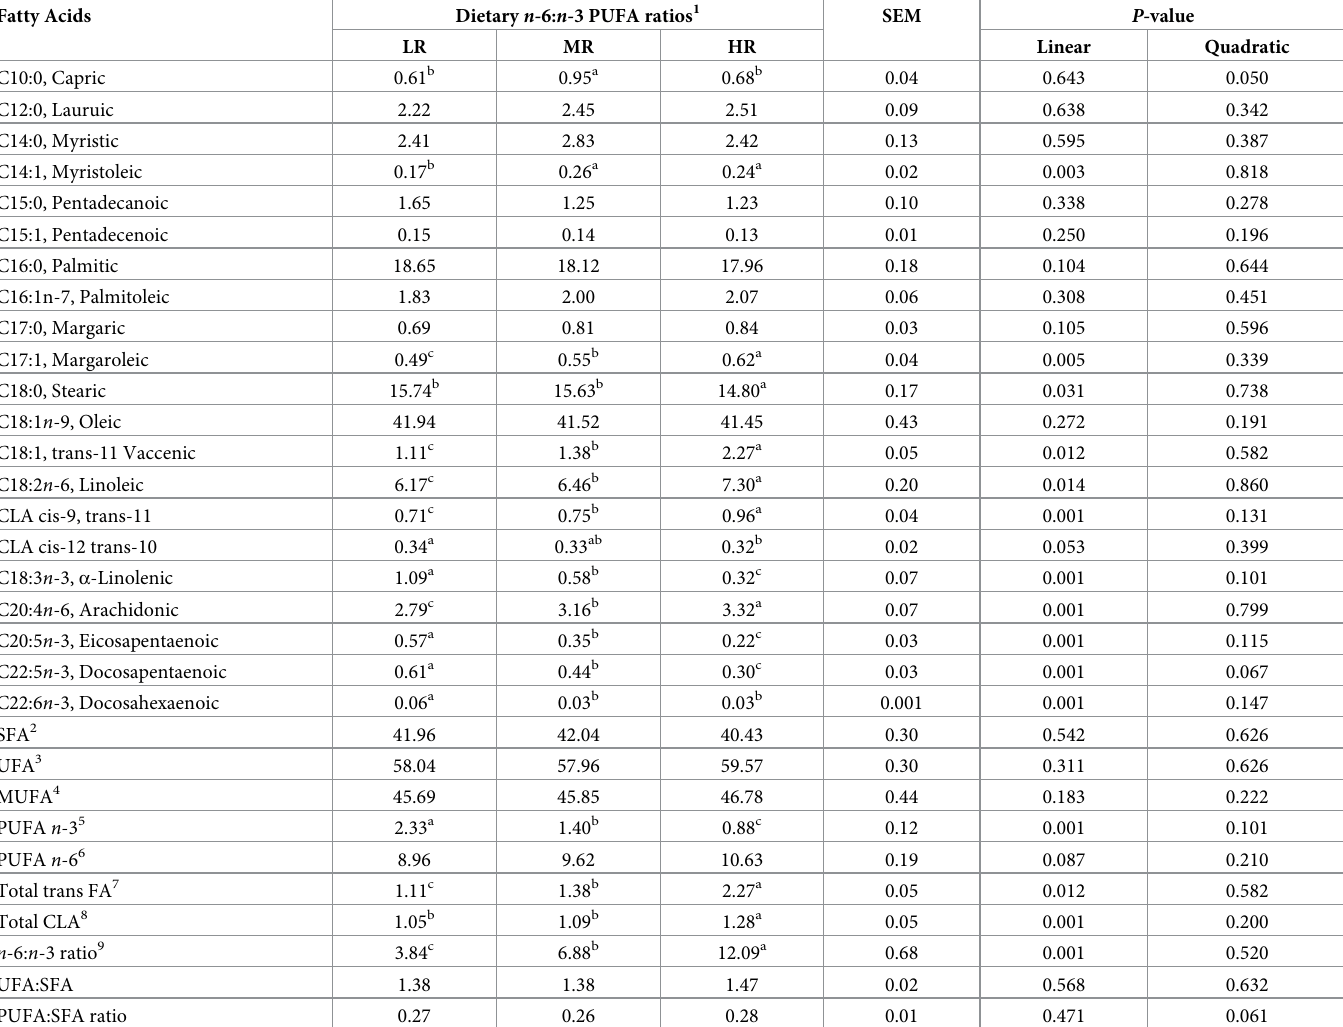
Table 7. Effect of dietary n -6: n -3PUFA ratios on FA composition (% of identified FAs) of longissimus dorsi in goats. Fatty Acids Dietary n -6: n -3 PUFA ratios